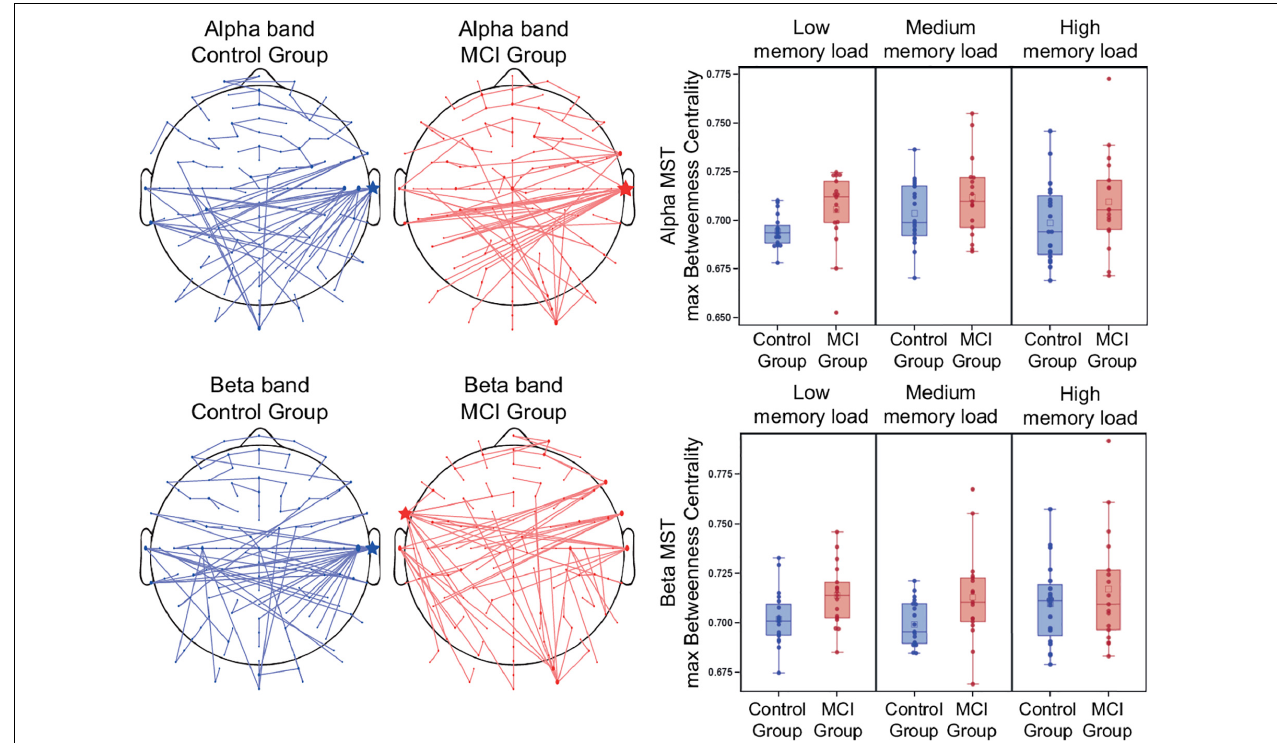
FIGURE 6 | Group MSTs and maximum Betweenness Centrality in the alpha and beta frequency band. Group-average MSTs of the two study groups (average of all levels of memory load). The size of the nodes are proportional to the number of their connections (degree). Hubs with the most connections are indicated by asterisks. Betweenness centrality is considered as one of the most important parameters for the identification of network